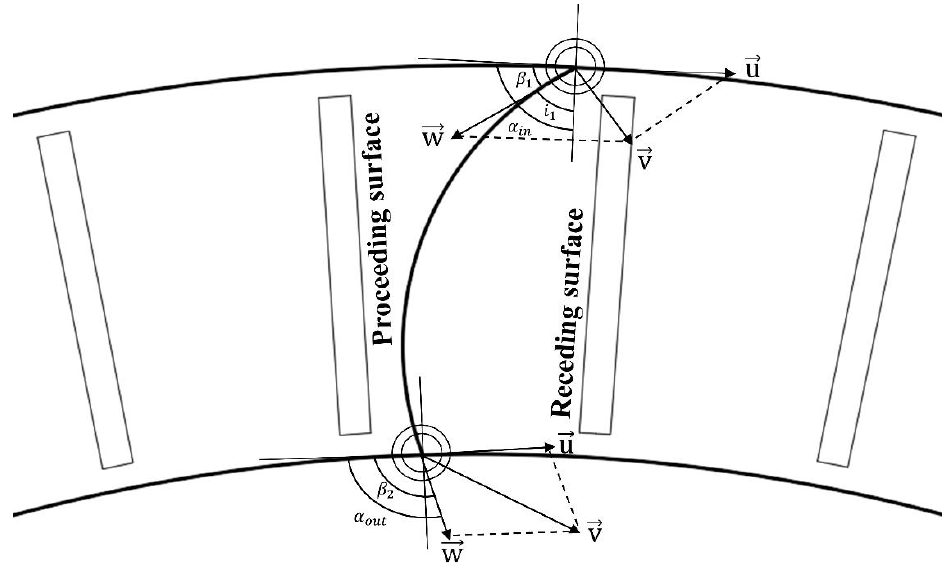
Figure 11. Analysis of the flow characteristics of the airflow in the rotor cage channel.